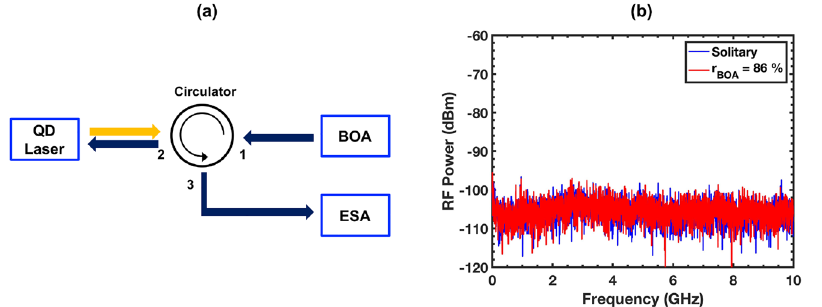
Figure 13: (a) Schematic representation of theincoherentEOFsetup.(b)RFspectrumin solitary case and under 86% incoherent EOF for the epitaxial QD laser on silicon at 3 × I s .